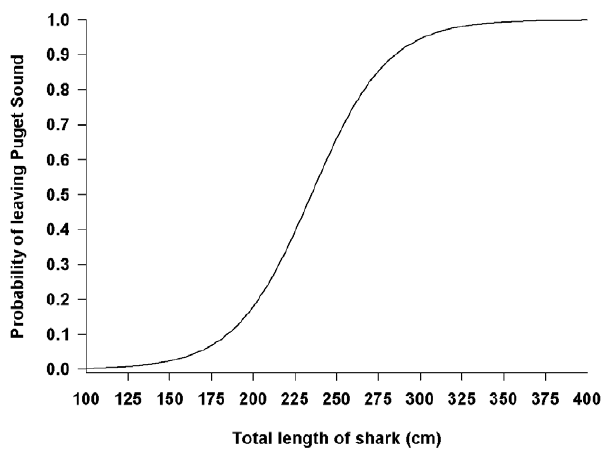
Figure 8. Probability of a female sixgill shark leaving Puget Sound, WA, USA as a function of the shark’s total